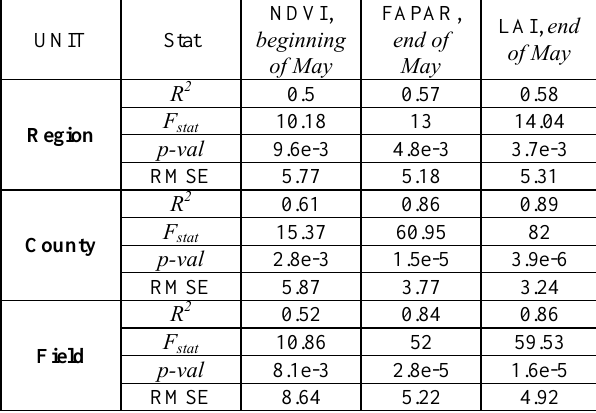
Table 2. Statistical properties of regression models at different scales